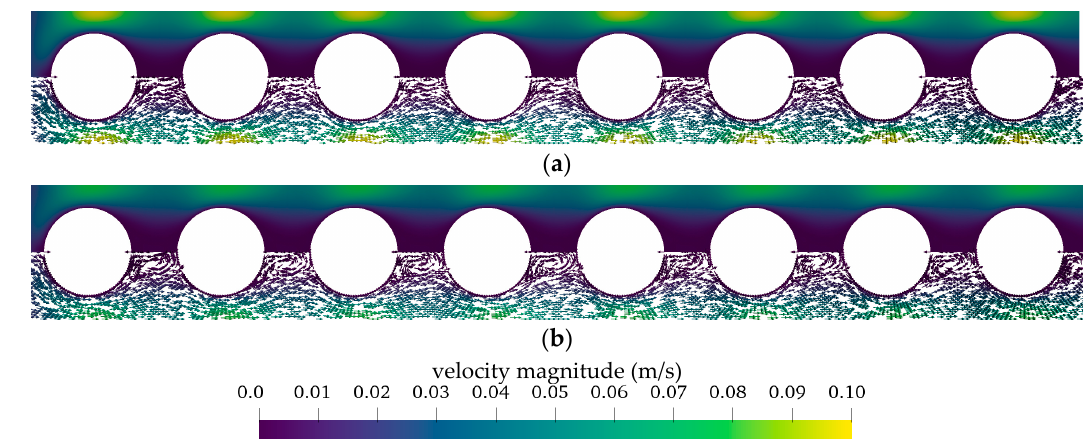
Figure 12. Flow distribution within the simplified packing ( a ) porcine blood ( b ) water. Bottom half of contour plot shows direction of velocity vectors.